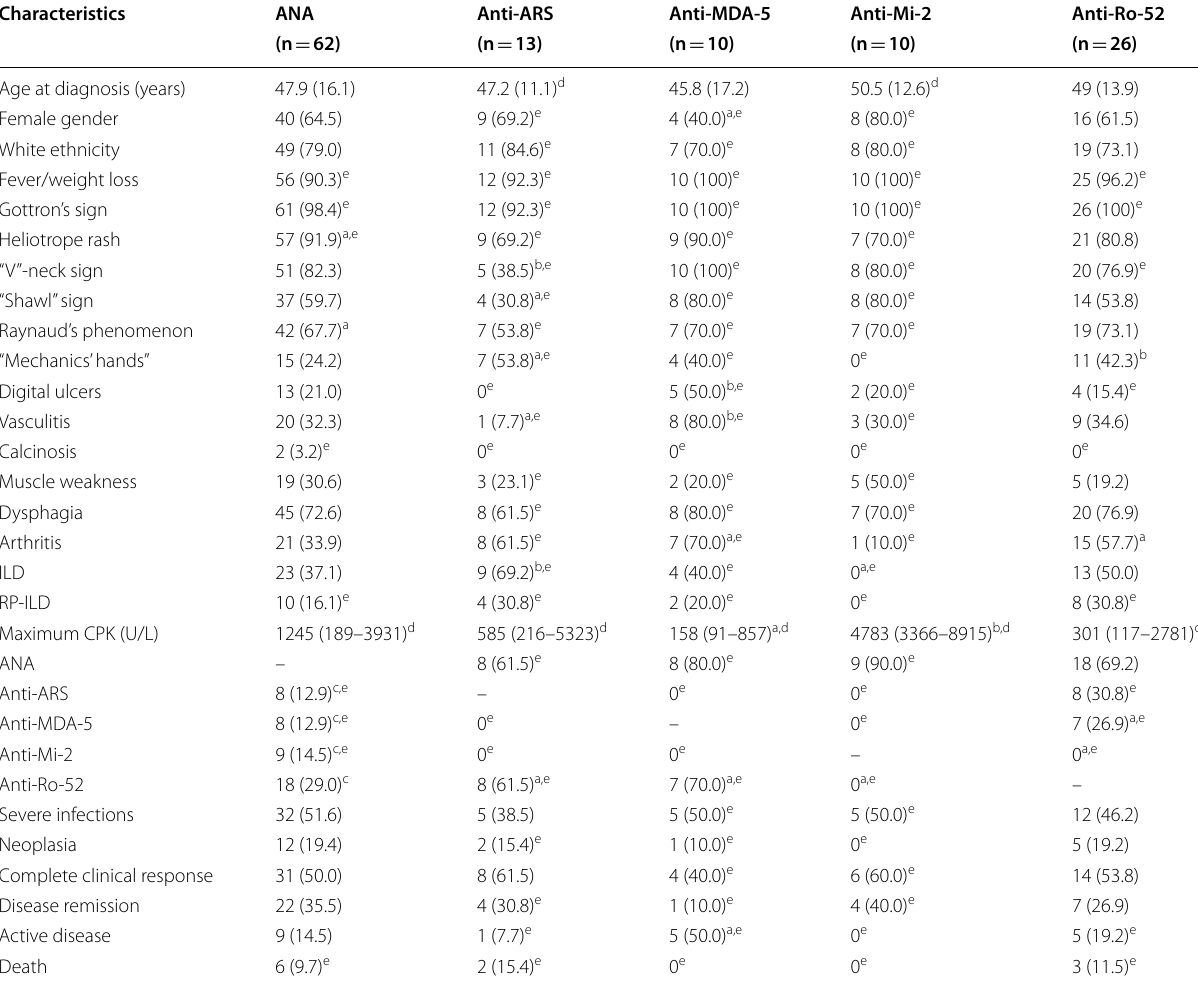
Table 4 Comparison of clinical, imaging, and laboratory features among different autoantibodies profiles in patients with